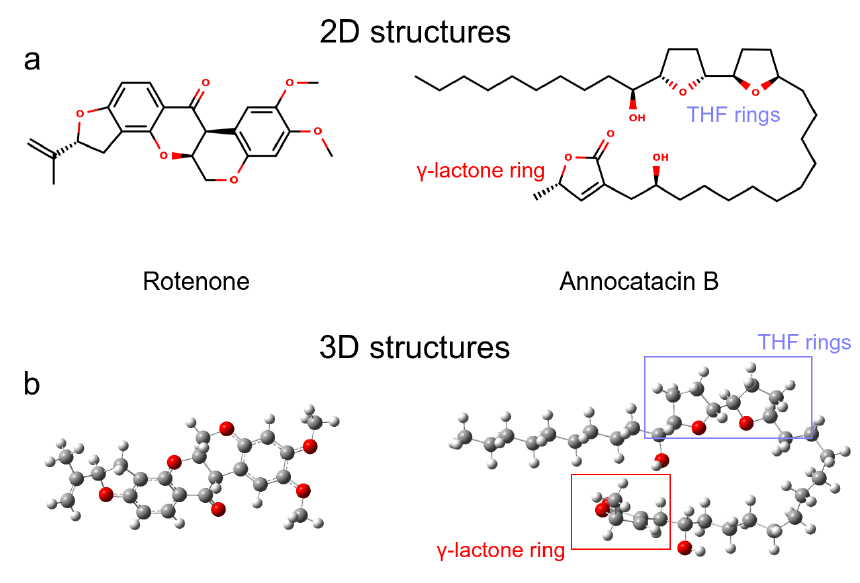
Figure 1. Ligand molecules used in this work. ( a ) 2D representations. ( b ) 3D representations obtained after QM